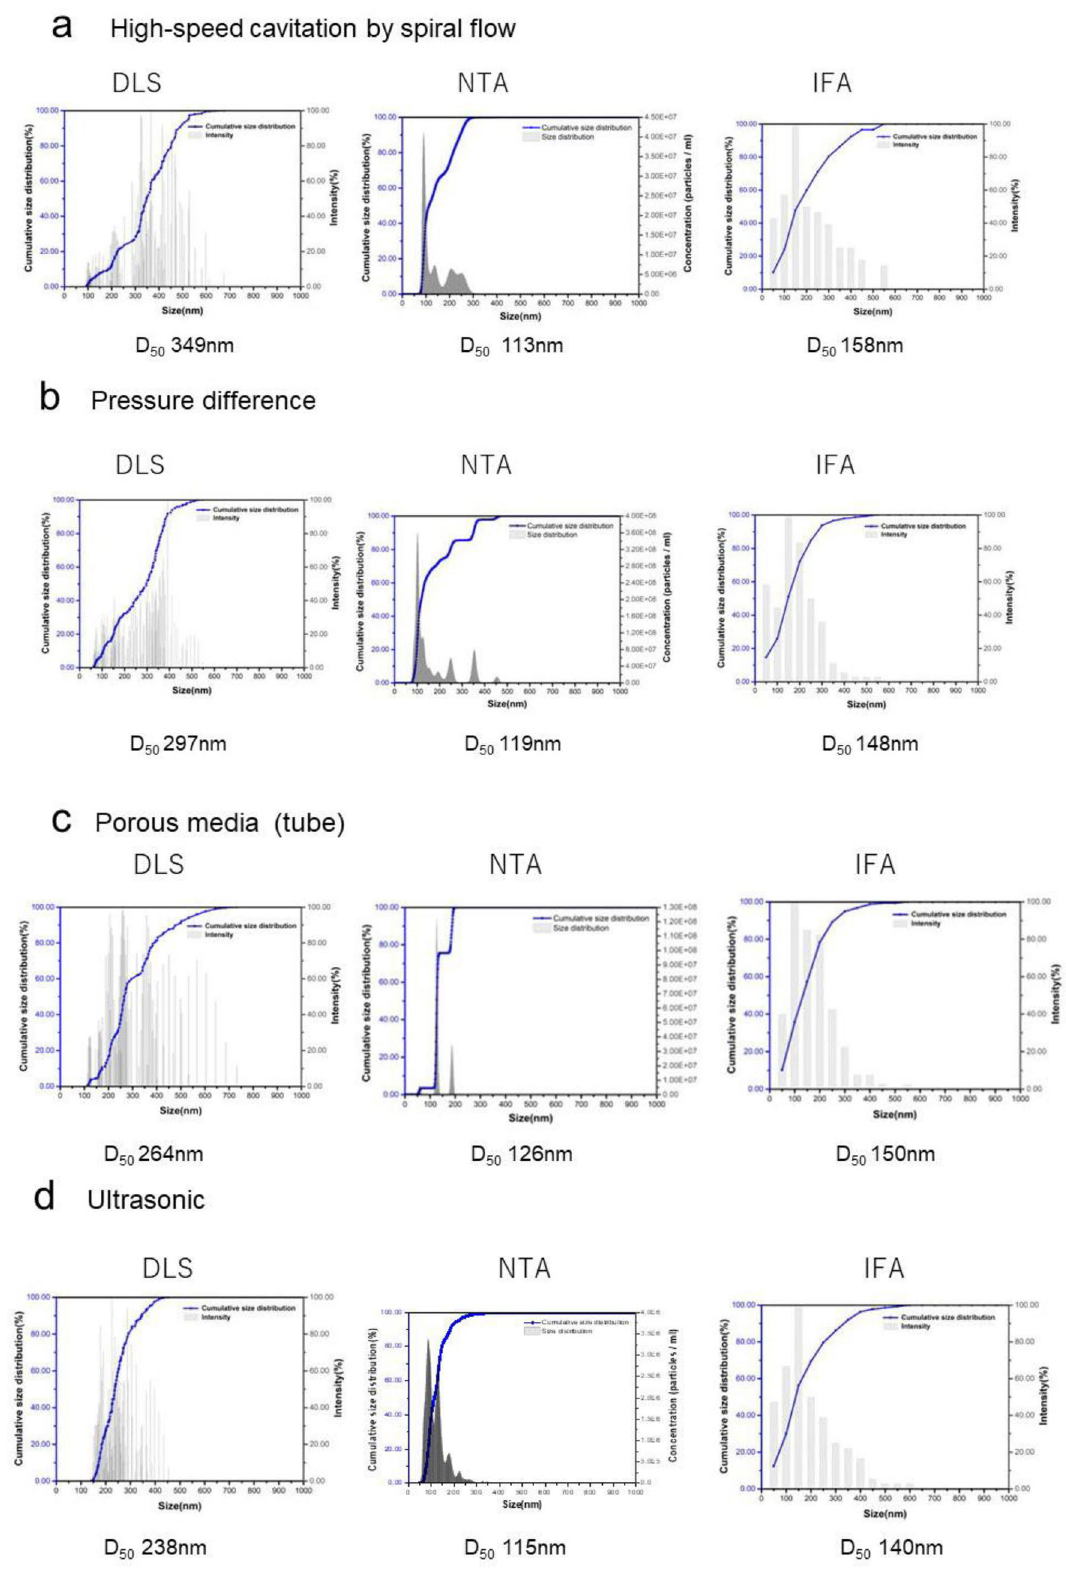
Figure 3. Nanobubble size distribution compared with different measurement methods at pH 10 water. ( a ) Nanobubble size distribution of three measurement methods (DLS, NTA, and IFA) and D 50 produced by the spiral flow. ( b ) Nanobubble size distribution of three measurement methods (DLS, NTA, and IFA) and D 50 produced by pressure difference. ( c ) Nanobubble size distribution of three measurement methods (DLS, NTA, and IFA) and D 50 diameter produced by porous media (tube). ( d ) Nanobubble size distribution of three measurement methods (DLS, NTA, and IFA) and D 50 produced by